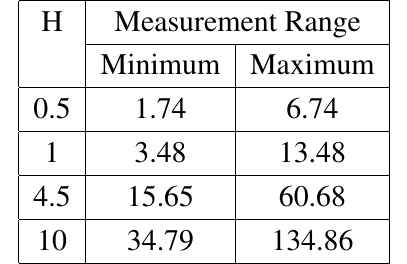
Table 5. Measurement range for a VGA camera (640 × 480). All values in centimeters.